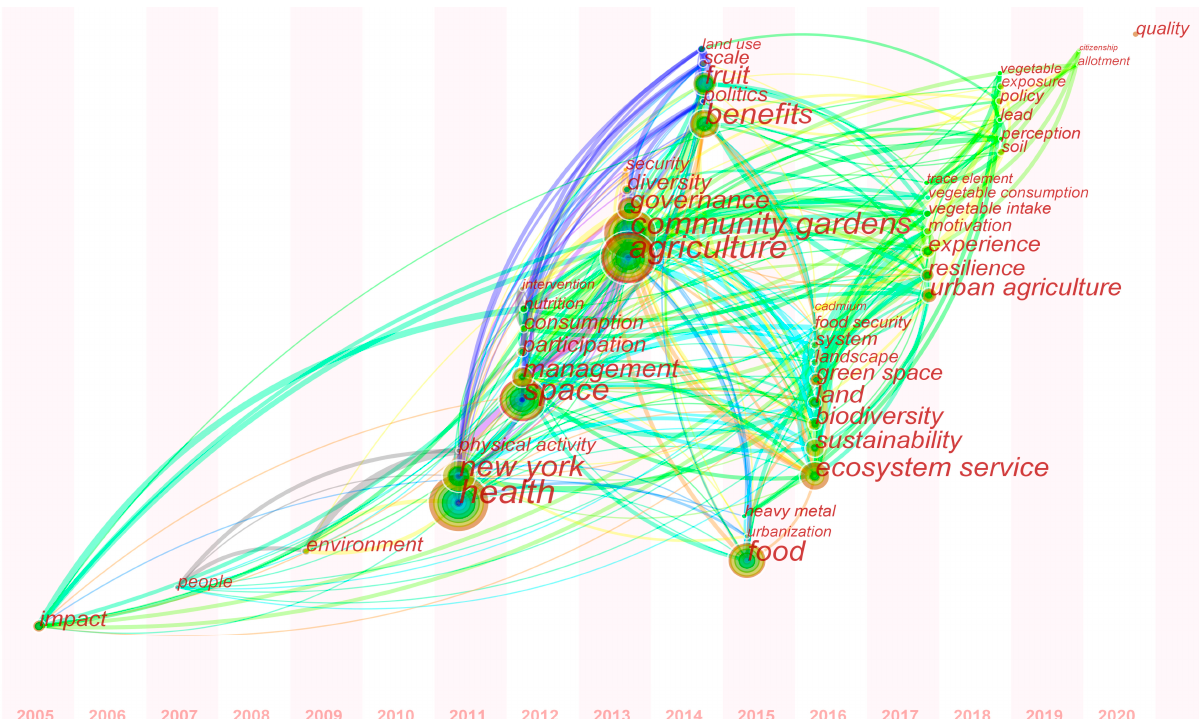
Figure 9. Top 50 keywords plus time-zone visualization of community gardens publications. The time-zone view consists of an array of vertical strips as time zones, which emphasizes the temporal relationships. The horizontal movement of an item is restricted to its own time zone, but its vertical movement is completely determined by its connections to items in other time zones.